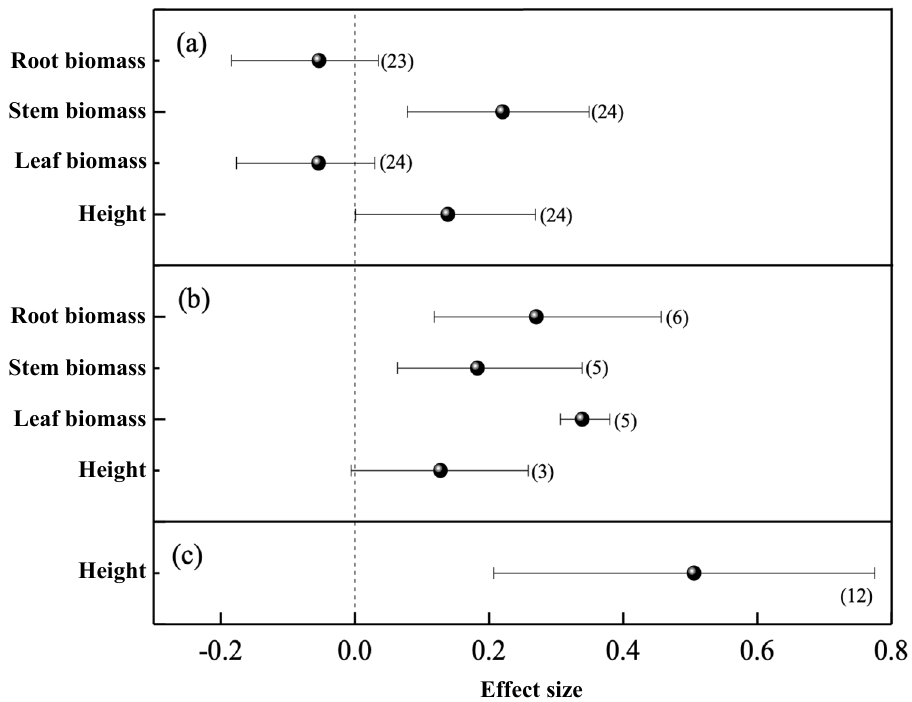
Figure 9. Mean effect size for seedling root, stem and leaf biomass, as well as height in greenhouse ( a ), common garden ( b ), and field ( c ) studies. Error bars represent 95% CIs.